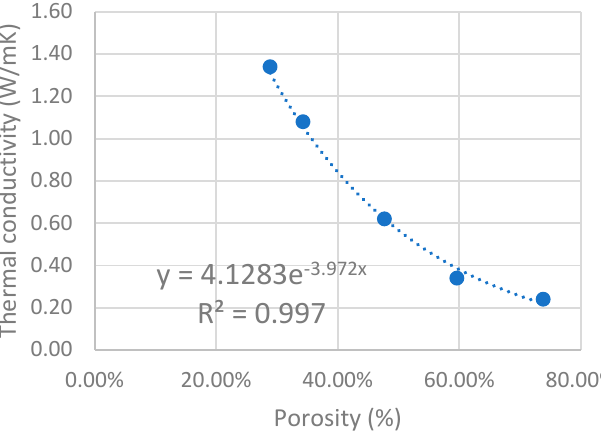
Figure 16. Correlation of vermiculite content, thermal conductivity, and porosity results from the study by Barros (2018) [17].